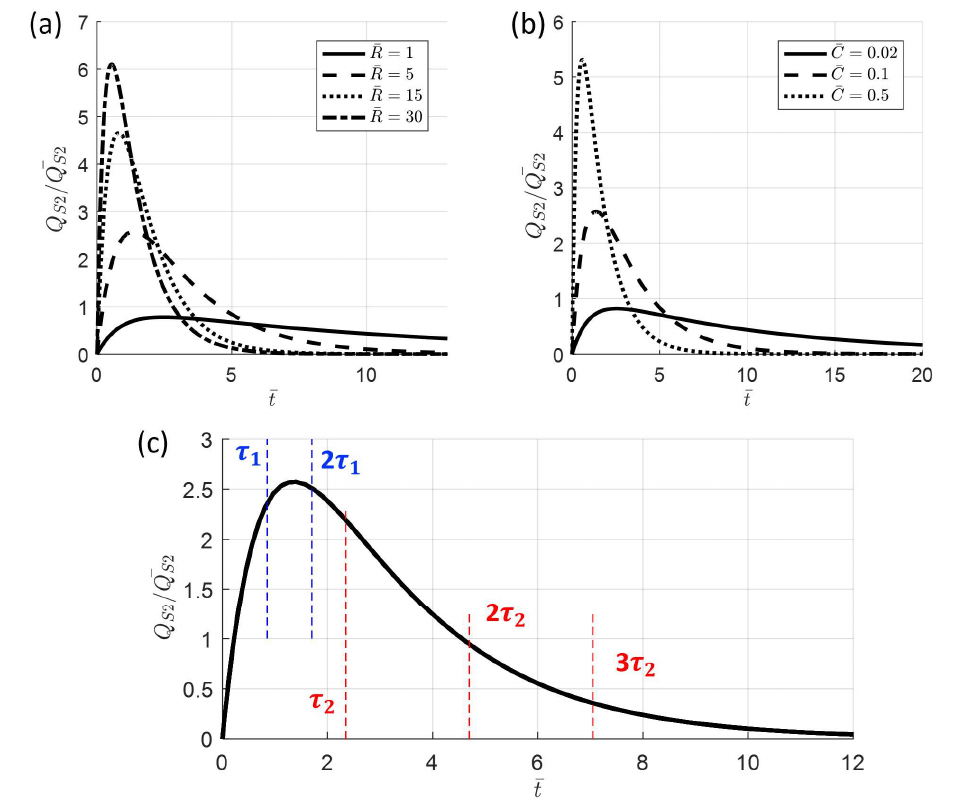
Figure 23. ( a ) Pressurization solution Q 2 with ¯ C = 0.1 and different ¯ R ( b ) pressurization solution Q2 Figure 23: (a) Pressurization solution Q2 with 𝑪(cid:3365) =0.1 and different 𝑹(cid:3365) (b) pressurization solution Q2 with 𝑹(cid:3365) =5 and different 𝑪(cid:3365) (c) Two time constants 𝝉 with ¯ R = 5 and different ¯ C ( c ) Two time constants τ 1 and τ 2 on the pressurization solution at ¯ C = 0.1 and ¯ R = 𝟓 .